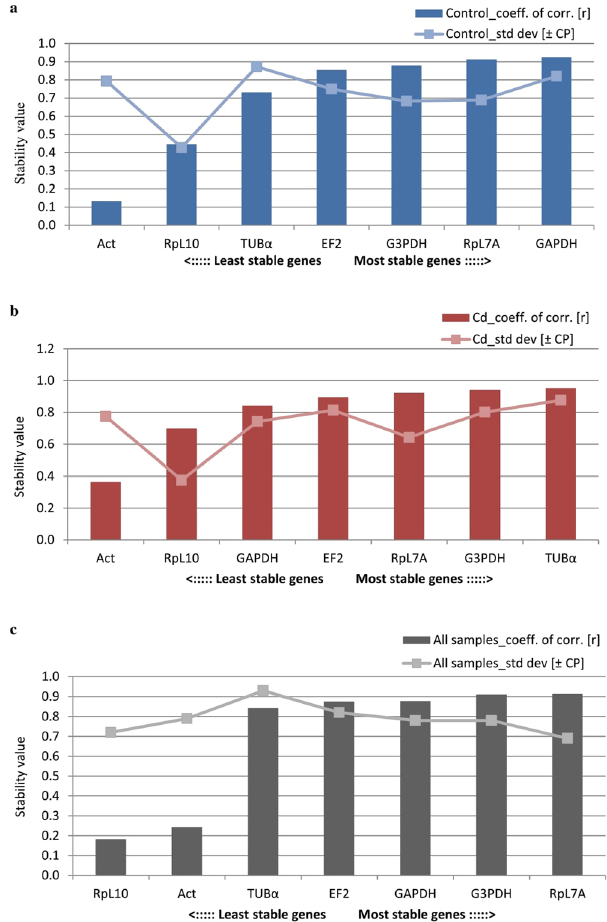
Figure 5. Expression stability of 7 candidate reference genes as calculated by BestKeeper. Abbreviations as in Fig.